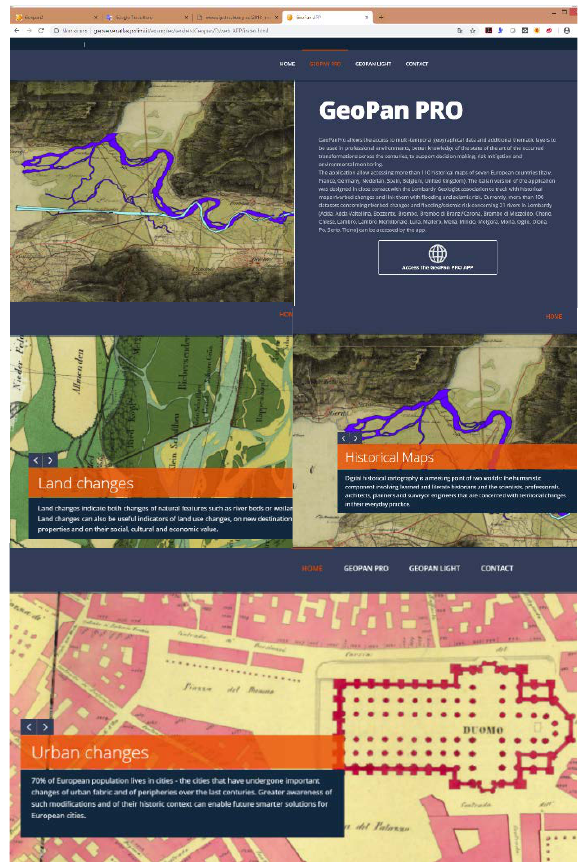
Figure 3. The GEOPAN APP: an application where to meet, discover and access Geographic Open Data based on Virtual Hub at the built environment domain (Lombardy Region) and urban domain (City of